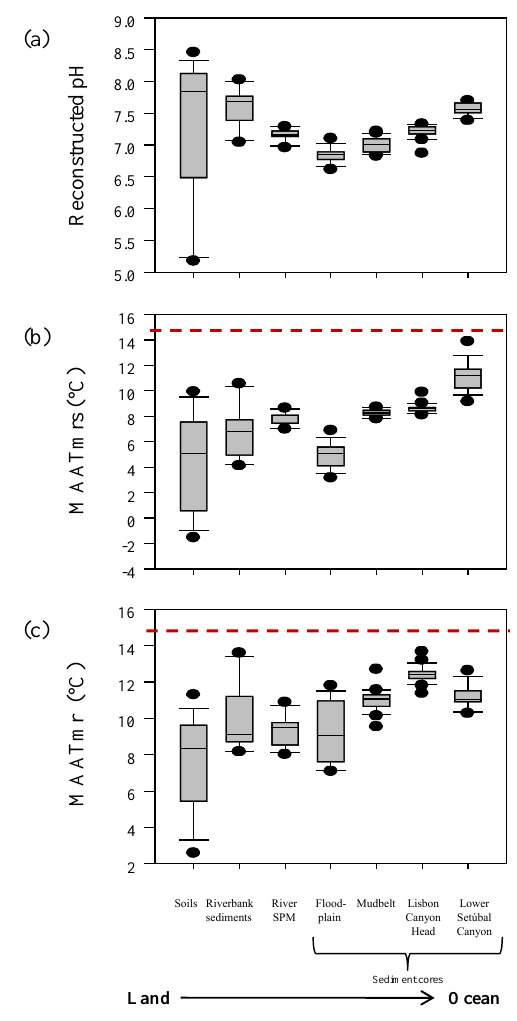
Figure 9. Box plots of all the sample sets within the transect from the land to the deep ocean off the Portuguese coast for (a) recon- structed pH, (b) MAT mrs ( ◦ C), and (c) MAT mr ( ◦ C). Red dotted line indicates estimated present-day MAT for the Tagus River basin (14.6 ◦